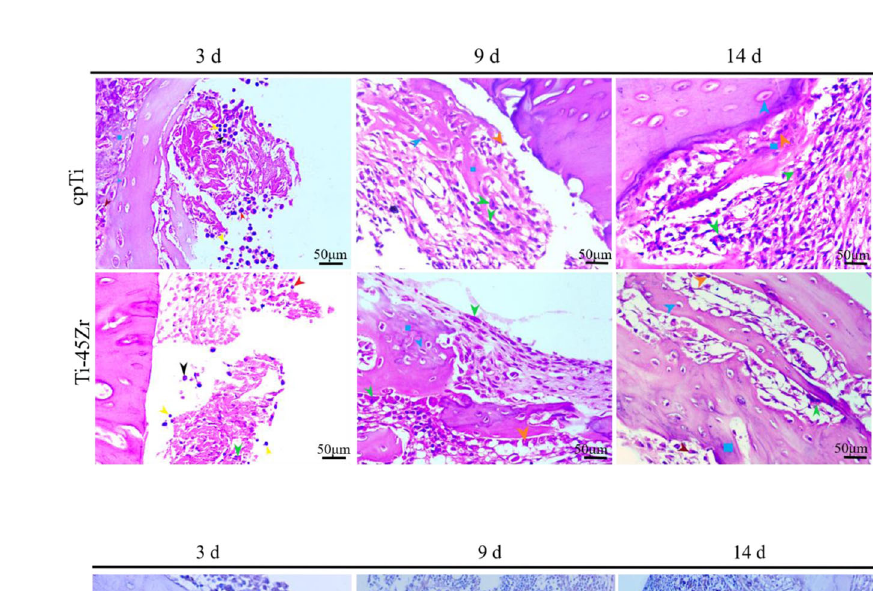
Fig. 8 CD68 immunohistochemical staining and histological observation of rats at 3, 9, and 14 d after the Ti- 45Zr alloy and cpTi implantation (red arrow indicates positive color area)